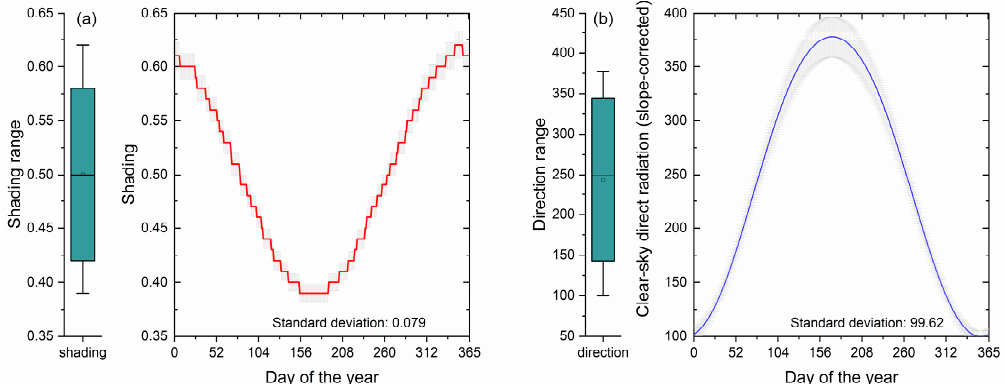
Figure 4. Annual slope corrected clear-sky potential radiation ( a ) and shading ( b ) at Qiyi Glacier surface. The centerlines in the box-and-whisker plots represent the mean, the box bounds refer to the 25th and 75th percentiles, and the whiskers represent minimum and maximum values. The error bars indicate a 5% percentage